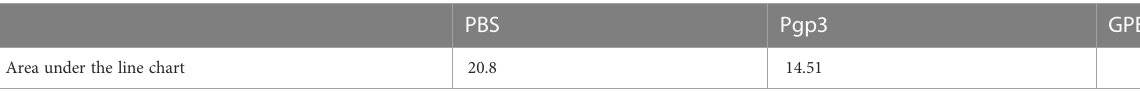
Area under the line chart